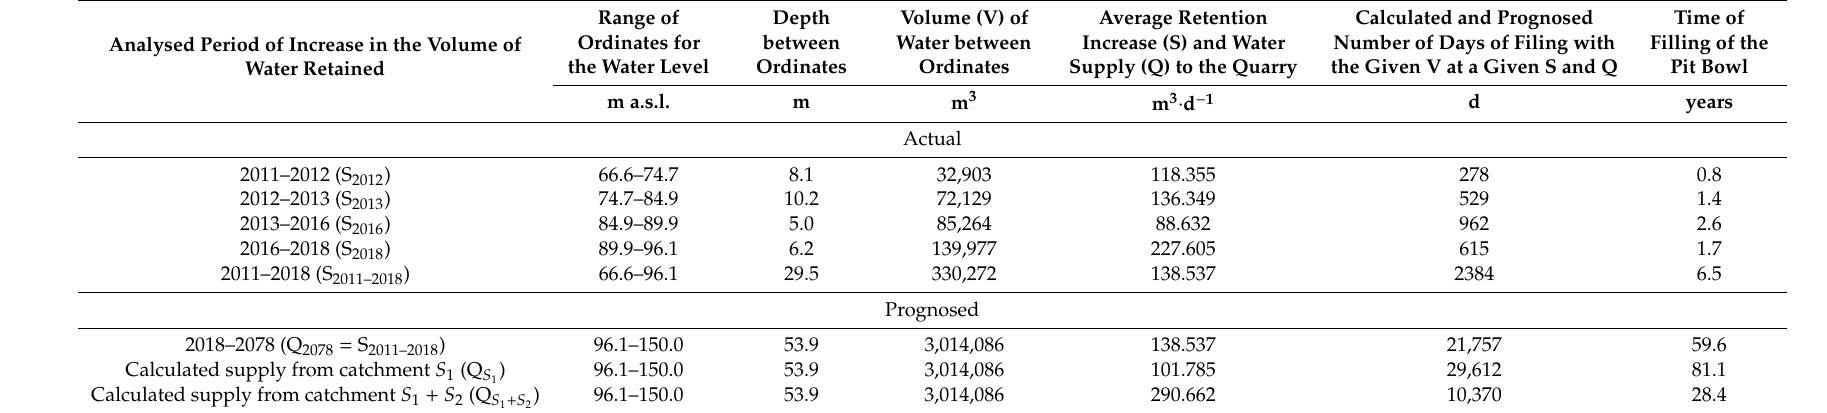
Table 2. Estimation results for the pace of filling the pit of the Strzelin I quarry with